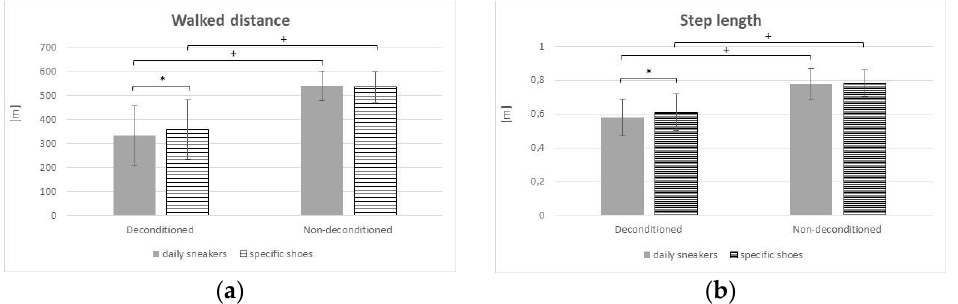
Figure 3. Mean and standard deviation of walked distance ( a ) and step length ( b ) during the i6MWT of the two groups are reported for the two sessions (daily sneakers vs. specific shoes). * = p < 0.05, sta- tistically significant in the post hoc comparison daily sneakers vs. specific-obesity shoes; + = p < 0.05, statistically significant in the post hoc comparison deconditioned vs. non-deconditioned